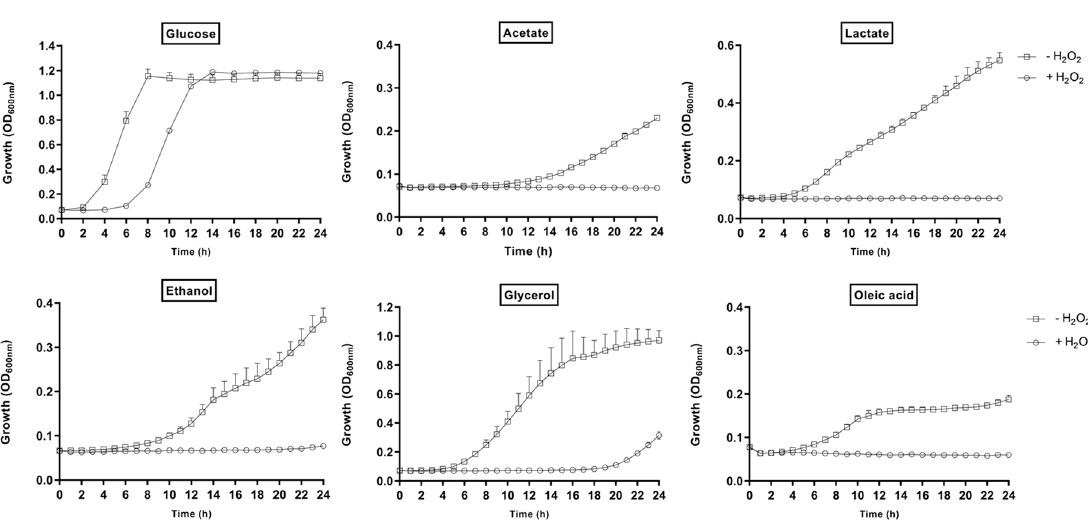
Figure 5. Alternative carbon sources affect the oxidative stress resistance of C. glabrata . Growth of C. glabrata in SC media supplemented with glucose or alternative carbon sources in the presence or absence of H 2 O 2 was monitored for 24 h at 37 °C.